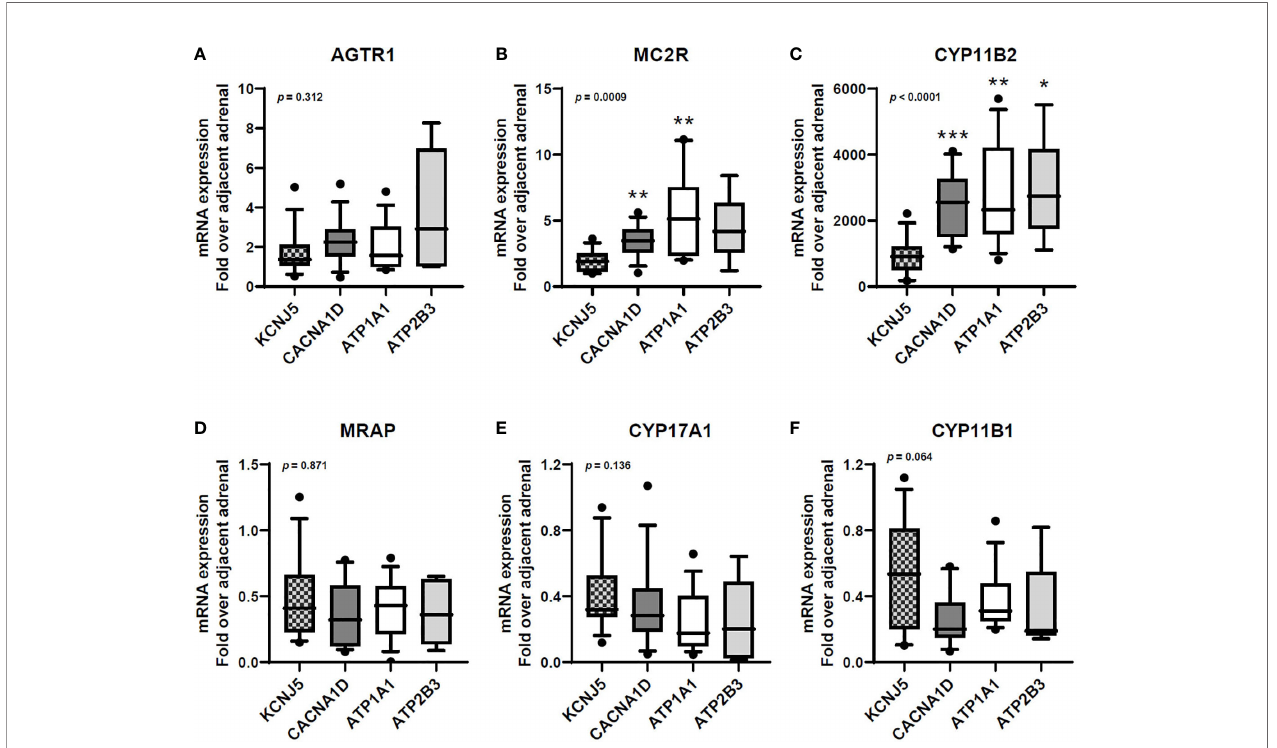
FIGURE 1 | Transcript expression of AGTR1 (A) , MC2R (B) , CYP11B2 (C) , MRAP (D) , CYP17A1 (E) , and CYP11B1 (F) in aldosterone-producing adenomas with different aldosterone-driver somatic mutations. qPCR data are shown as the fold changes normalized to b -actin (ACTB). AGTR1 , type 1 angiotensin II receptor; MC2R , melanocortin type 2 receptors (ACTH receptors); CYP11B2 , aldosterone synthase; MRAP , melanocortin 2 receptor accessory protein; CYP17A1 , 17 a - hydroxylase; CYP11B1 , 11 b -hydroxylase. Comparisons between groups were done using the Kruskal-Wallis test, followed by the Dwass-Steel-Critchlow-Fligner test. * p < 0.05, ** p < 0.01, *** p < 0.001, compared with KCNJ5 -mutated APAs. The boxes contain the 25 th and 75 th percentiles, the whiskers mark the 10 th and 90 th percentiles, and the horizontal line within the box indicates the median, and the ⚫ represent